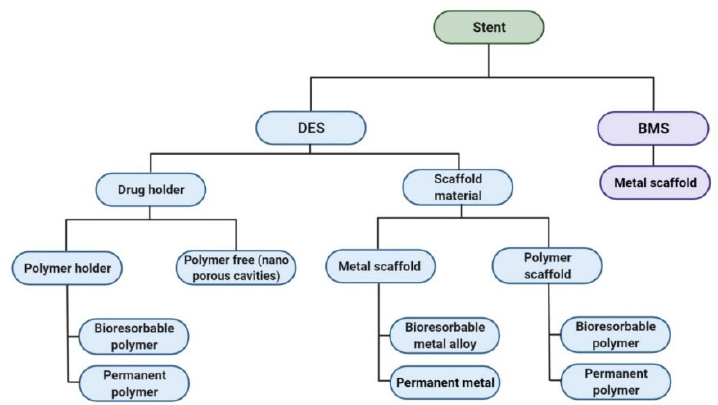
Figure 4. Schematic of the material choice in the various stents [19,23–30] .